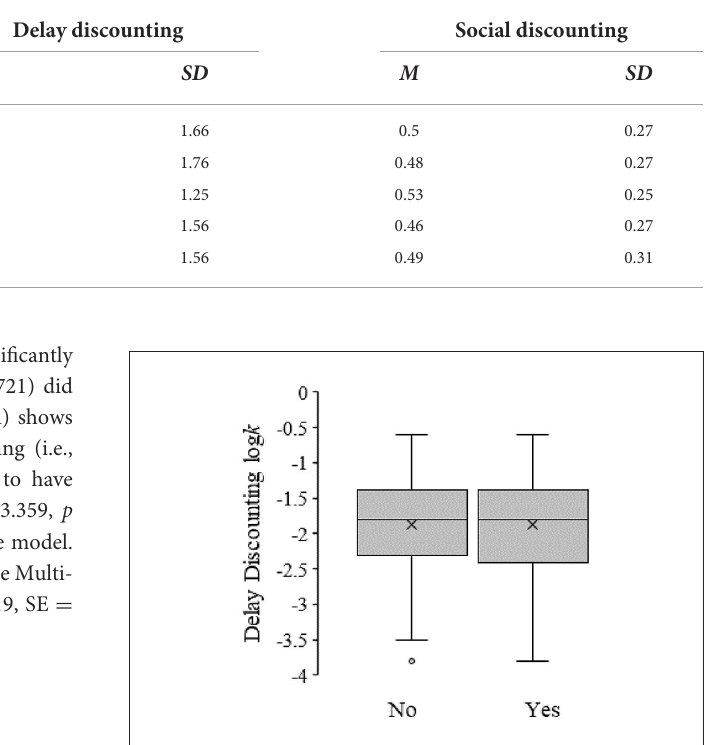
TABLE 2 Discounting means and standard deviations by ethnic group.